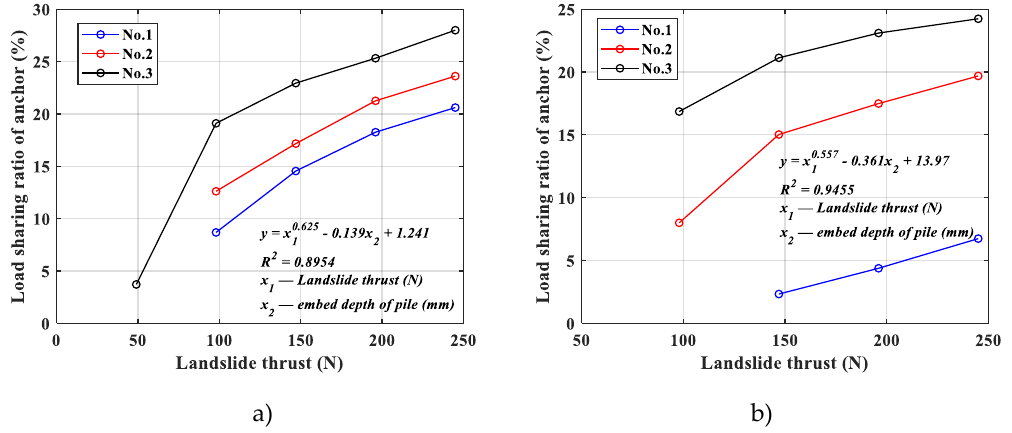
Figure 7. Load sharing ratio of anchor. ( a ) Ratio in epoxy resin pile model, ( b ) ratio in aluminum alloy pile model.